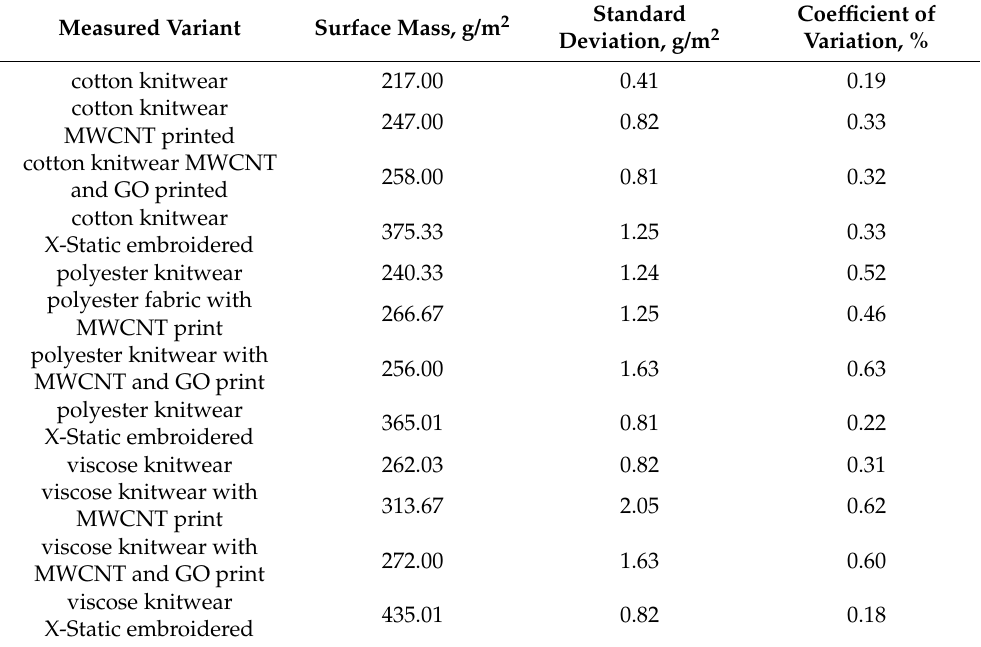
Table 2. Values of surface masses in textile materials before and after